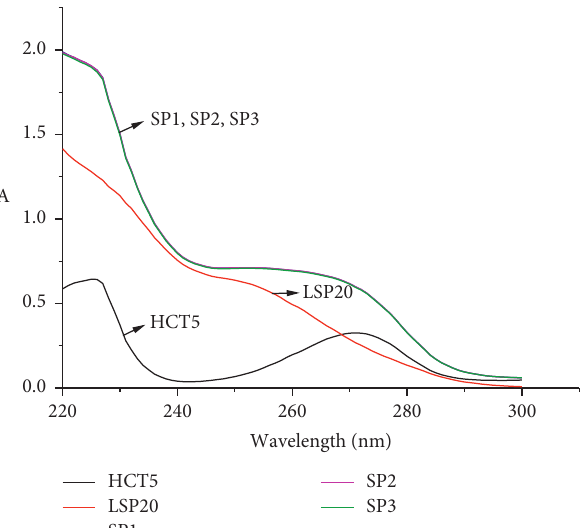
Figure 2: Absorption spectra of HCTand LSP standard solutions and Splozarsin Plus sample solutions. HCT5: standard solution of HCT